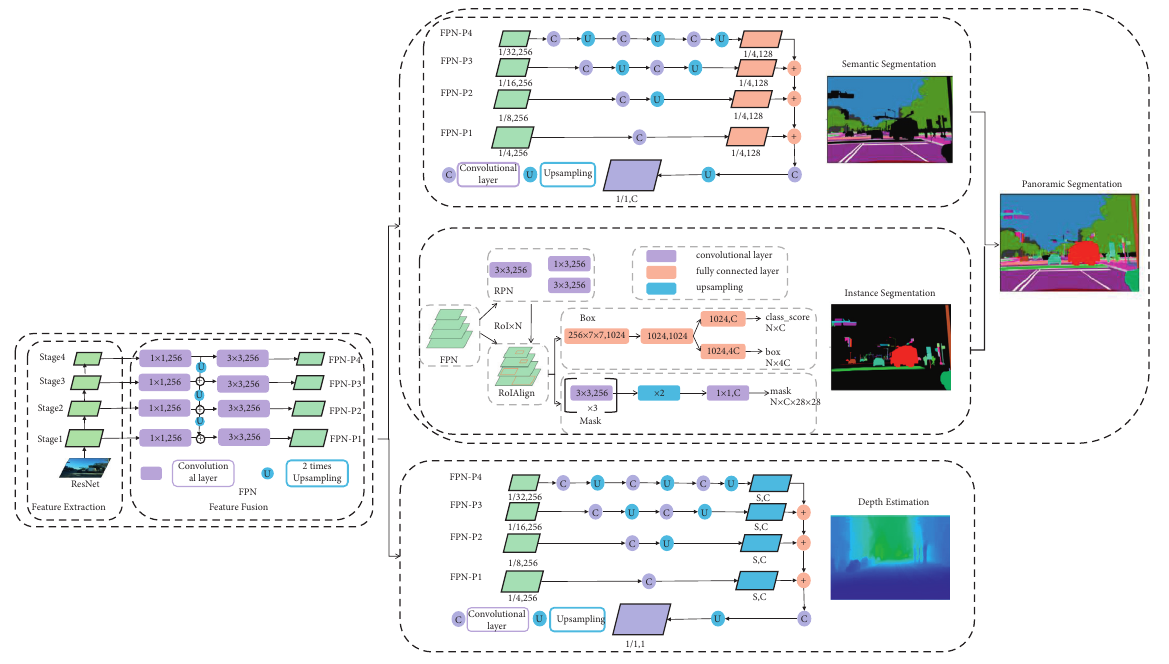
Figure 2: Overall neural network